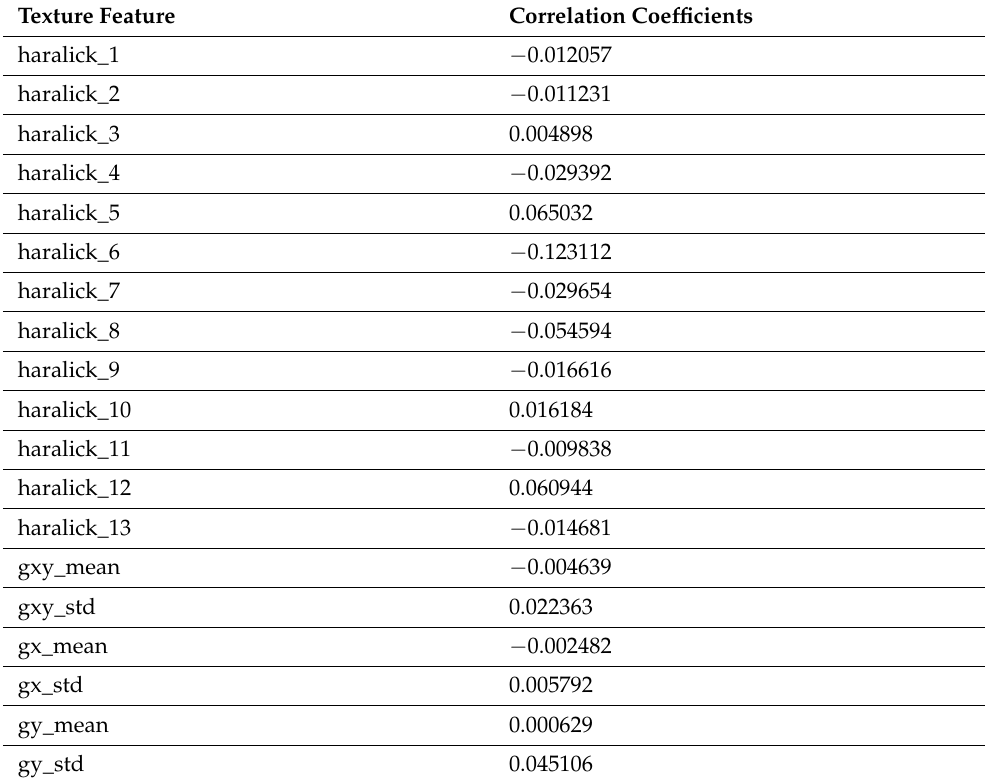
Table 3. Correlations between texture features and cabbage growth